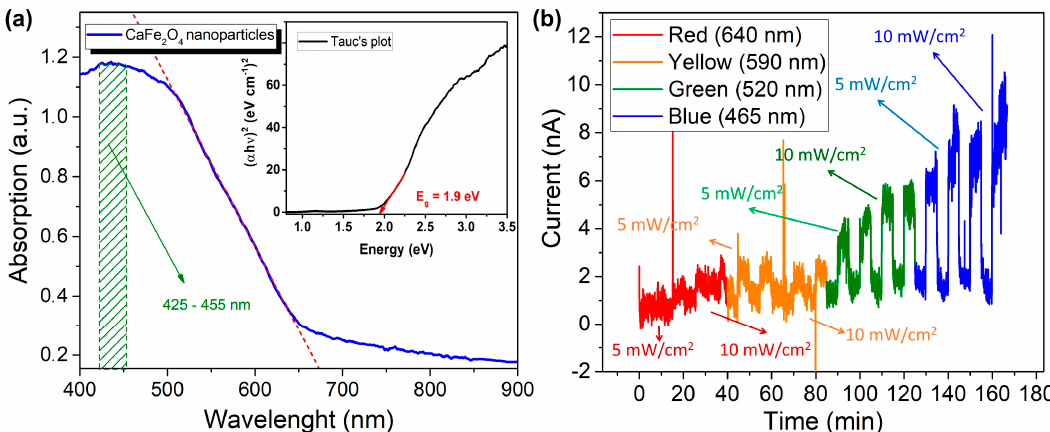
Figure 3. Optoelectronic characteristics of CaFe 2 O 4 nanoparticles. ( a ) Ultraviolet–visible (UV–vis) diffuse reflectance spectra (DRS) and Tauc’s plot ( b ) CaFe 2 O 4 behavior with different wavelengths and intensities (i.e., 5 and 10 mW/cm 2 ) of light-emitting diode (LED) confirming that CaFe 2 O 4 is suitable with the visible light energy.